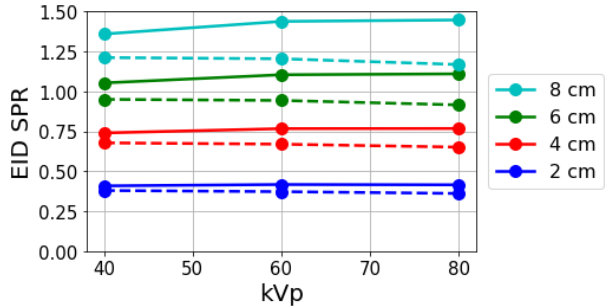
Figure 4. Simulated scatter-to-primary ratio (SPR) values using (solid) a 300 µ m thick silicon energy-integrating detector (EID) and (dashed) an ideal EID as a function of kVp for different object thicknesses at a fixed 0.5 cm air